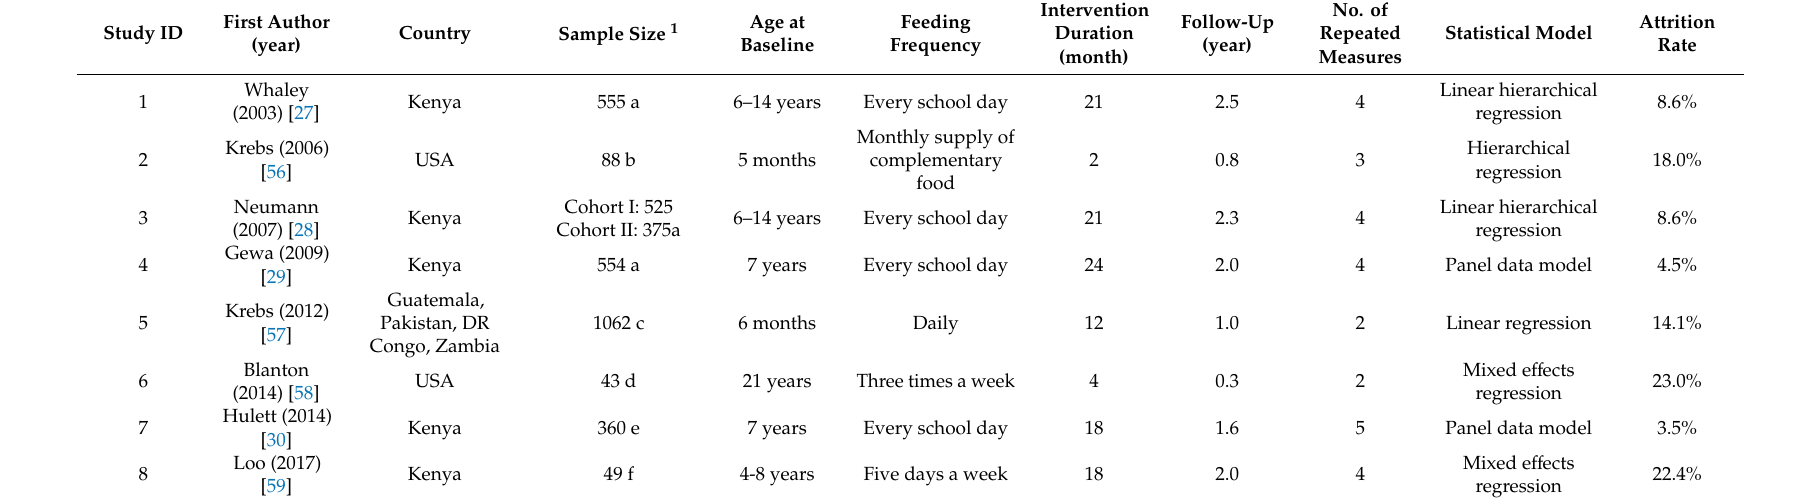
Table 1. Basic characteristics of the studies included in the